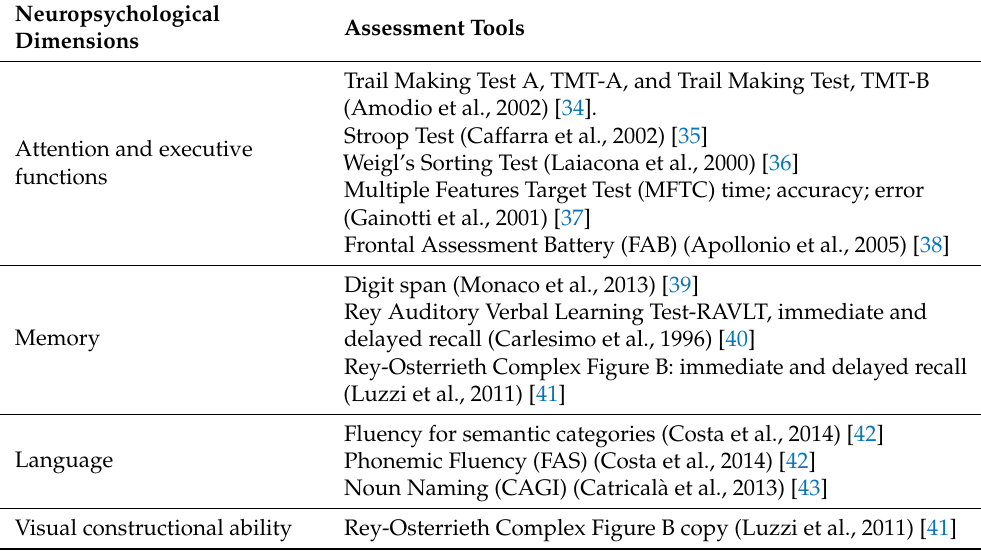
Table 1. Extensive neuropsychological